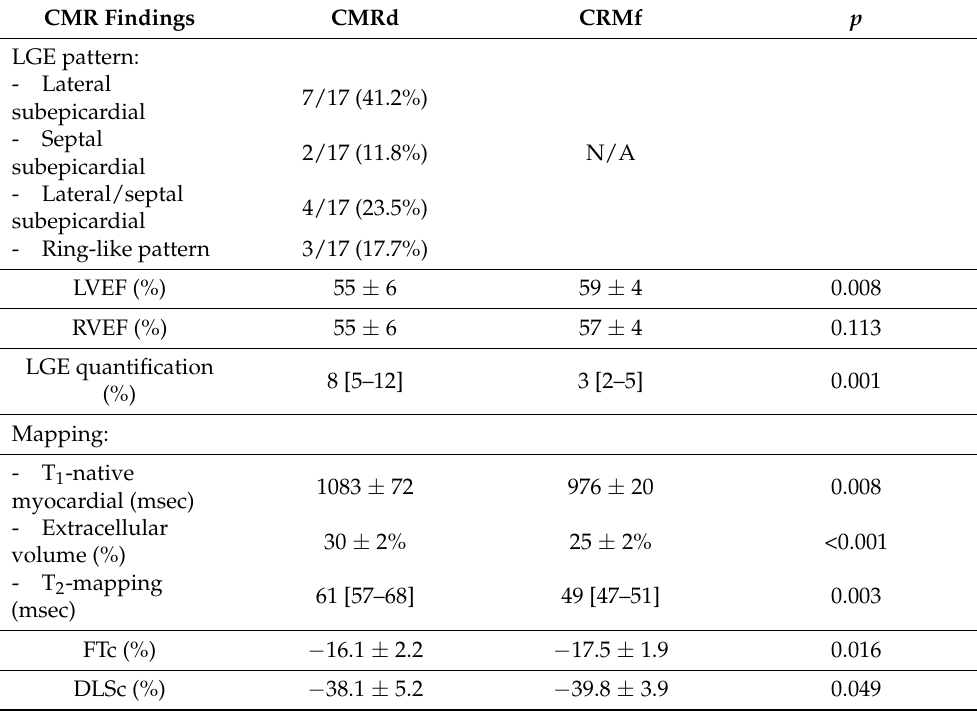
Table 2. Findings of diagnostic and control cardiac magnetic resonance imaging (n, %, unless otherwise indicated).